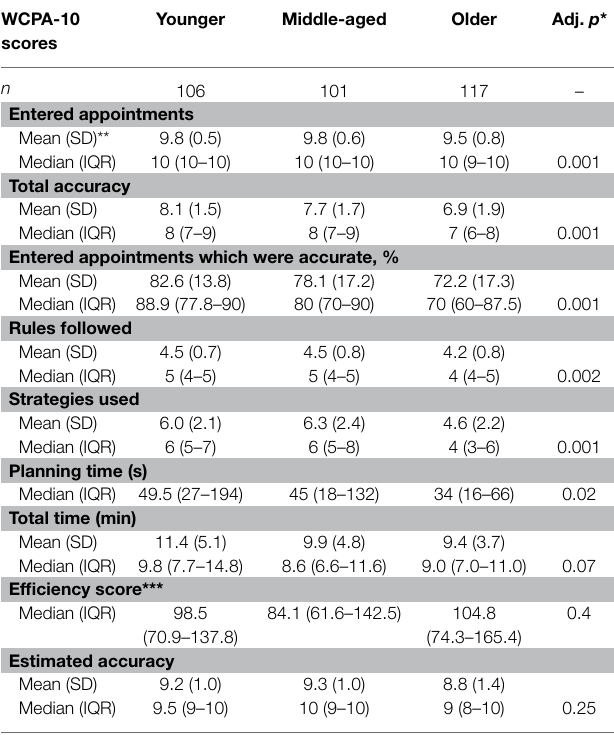
Five individual strategies were used by at least 50% of one